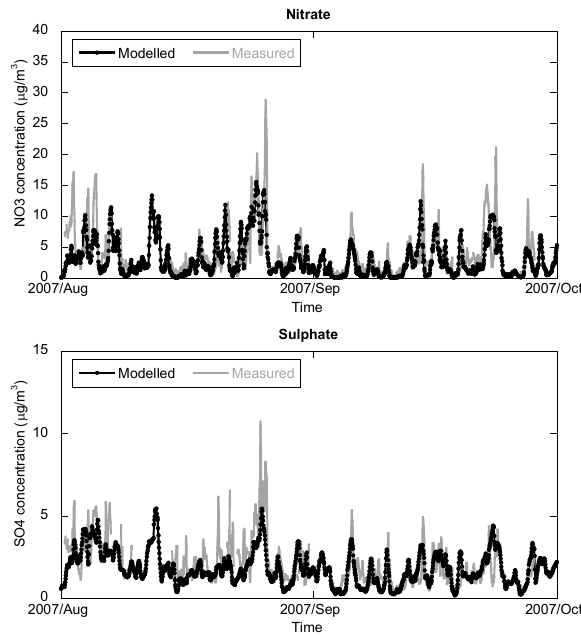
Fig. 5. Comparison of the measured (grey) hourly concentrations of Figure 5. Comparison of the measured (grey) hourly concentrations of nitrate and sulphate at 4 nitrate and sulphate at Cabauw with 7km grid resolution estimates Cabauw with 7 km grid resolution estimates (black) of the LOTOS-EUROS model for Aug-5 (black) of the LOTOS-EUROS model for August–September Sep 2007. 6